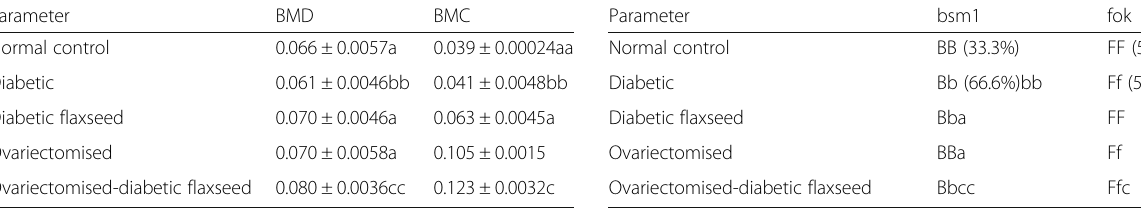
Table 3 Level of BMC (g), BMD (g cm/2) in the studied groups